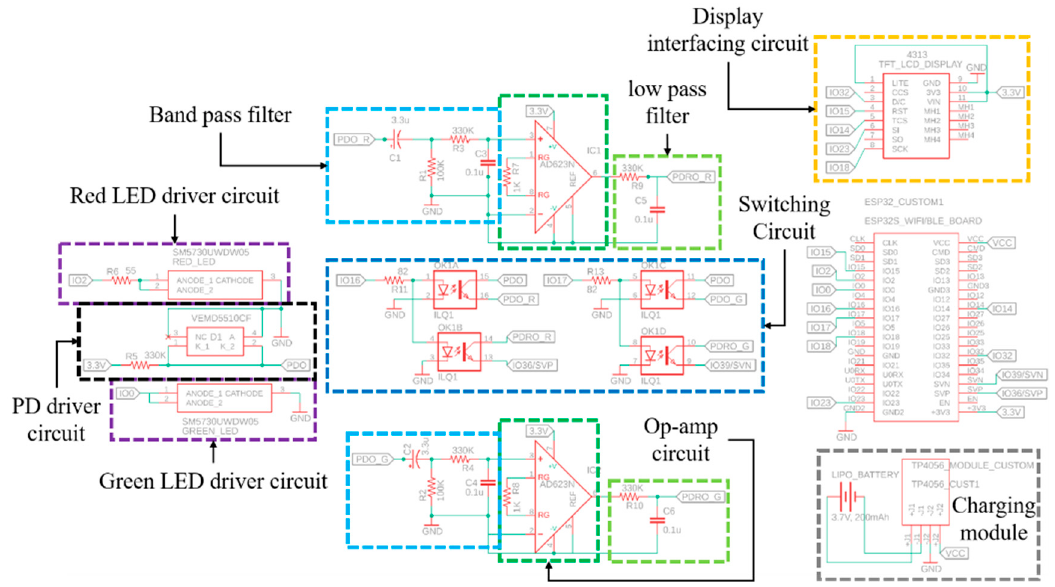
Figure 7. Complete schematic diagram of the proposed electronic circuit.